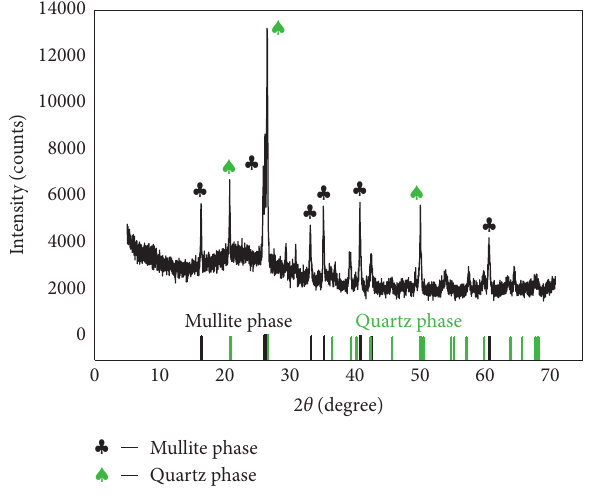
Figure 11: The XRD spectrum of fly